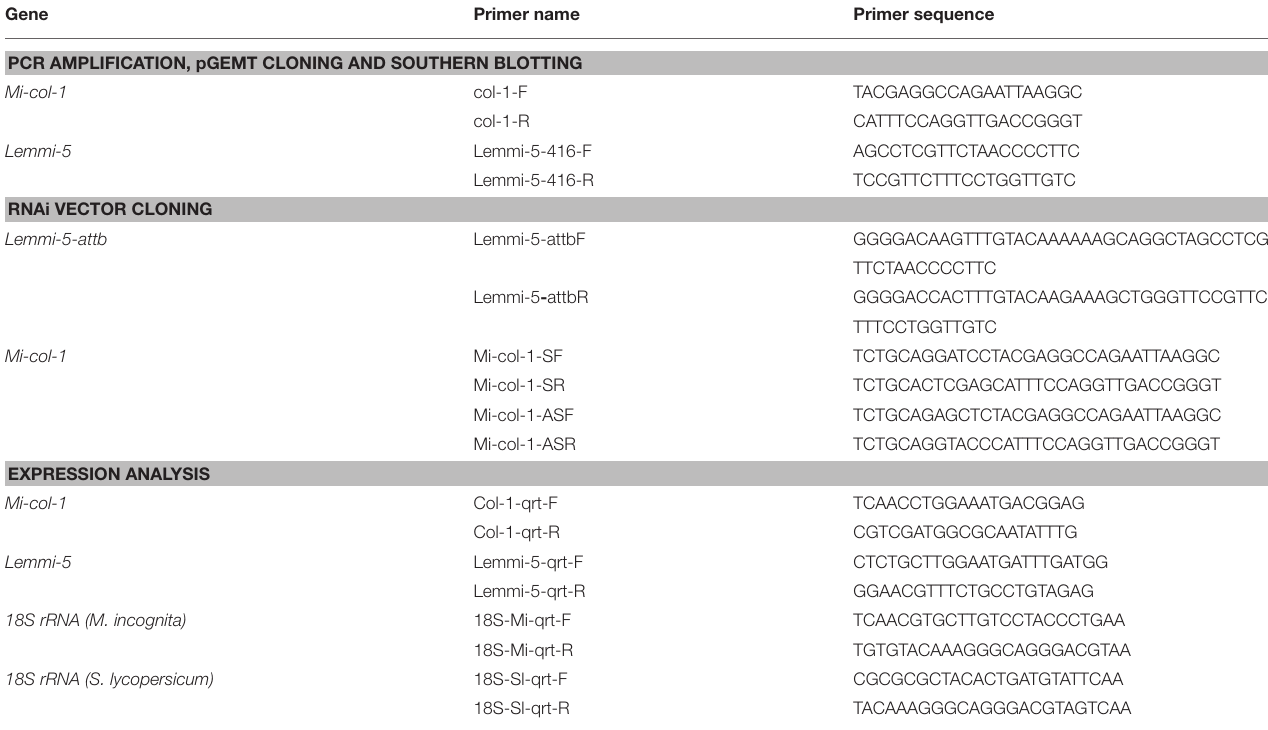
TABLE 1 | List of primers used for PCR amplification, pGEMT cloning and southern blotting, RNAi vector cloning and expression analysis.